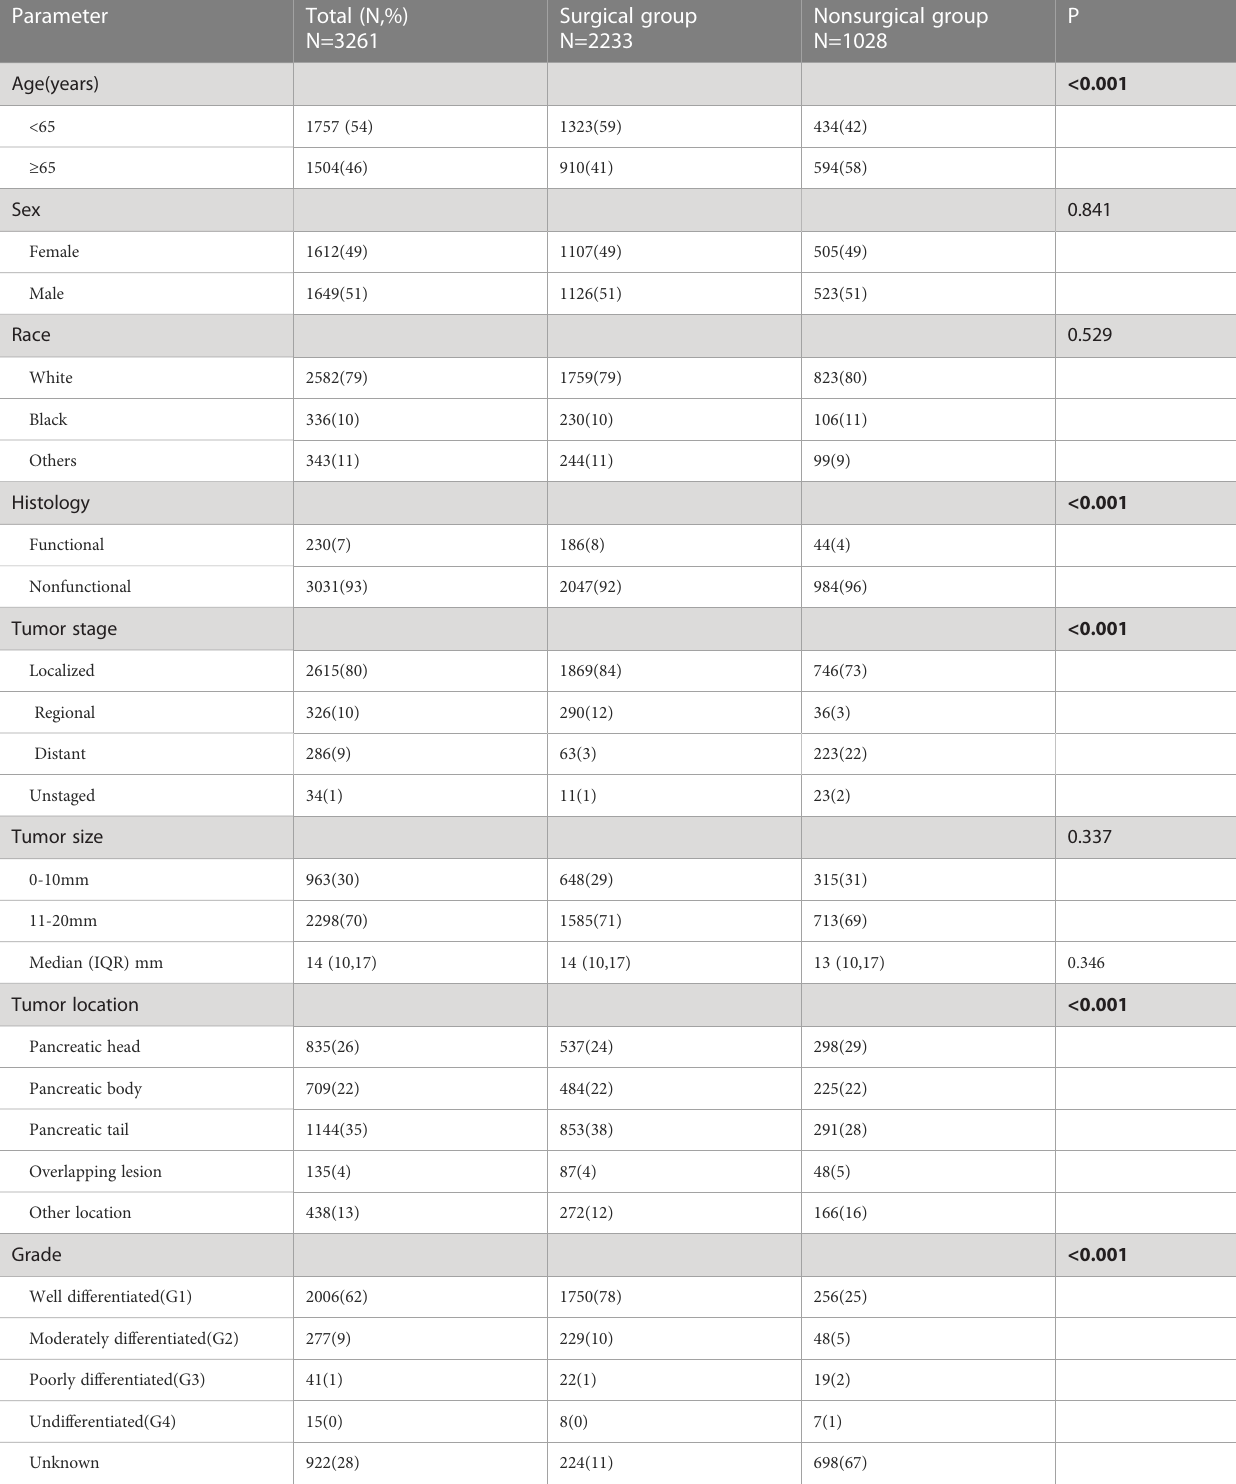
TABLE 1 Demographic and patient characteristics in the